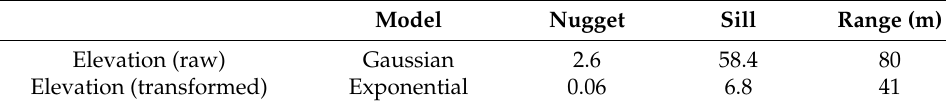
Table 2. Block model geometrical parameters.